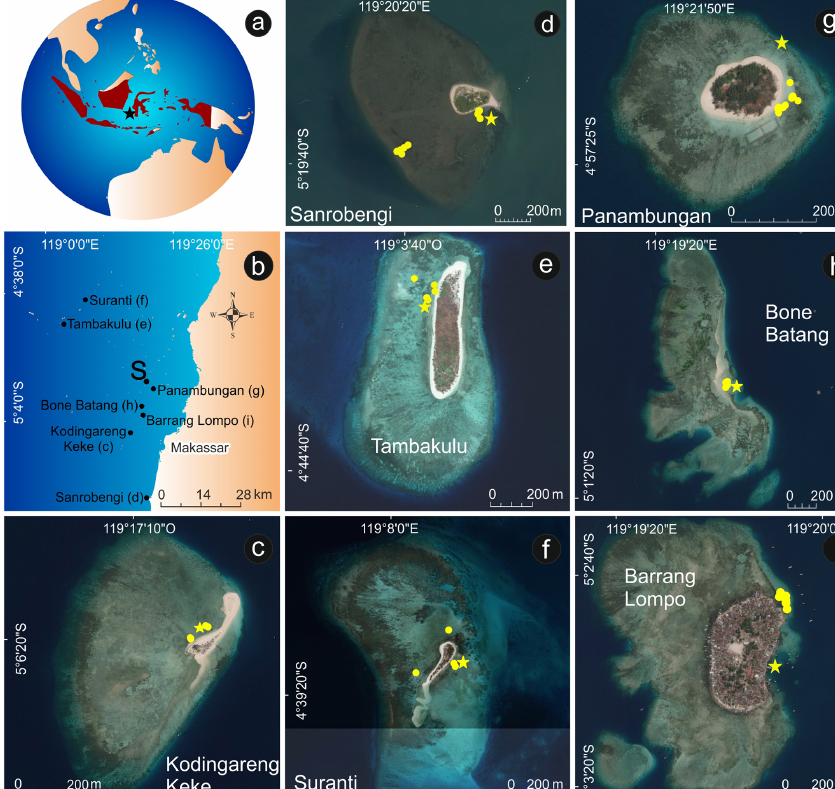
Figure 1. Overview map of the islands investigated in this study and the two islands studied by Mann et al. (2016) (Panambungan and Barrang Lompo). The star in (a) indicates the location of the Spermonde Archipelago, off the coast of southwestern Sulawesi; (b) indicates the position of each island, and the dot labeled “S” indicates the position of Sanane, where only living microatolls were surveyed. Insets (c–i) show each island. The yellow dots in these panels indicate the location of sampled fossil microatolls, while the yellow asterisks indicate the position of the tide pressure sensor. Imagery sources for panels (a, b) : Global Self-consistent Hierarchical High-resolution Shorelines from Wessel and Smith (1996); for (c–i) : Esri, DigitalGlobe, GeoEye, Earthstar Geographics, CNES/Airbus DS, USDA, USGS, AeroGRID, IGN, and the GIS User Community. The background maps in Fig. 1 were created using ArcGIS ® software by Esri. ArcGIS ® and ArcMap™ are the intellectual property of Esri and are used herein under license. Copyright© Esri. All rights reserved. For more information about Esri ® software, please visit https://www.esri.com/en-us/home (last access: 11 May